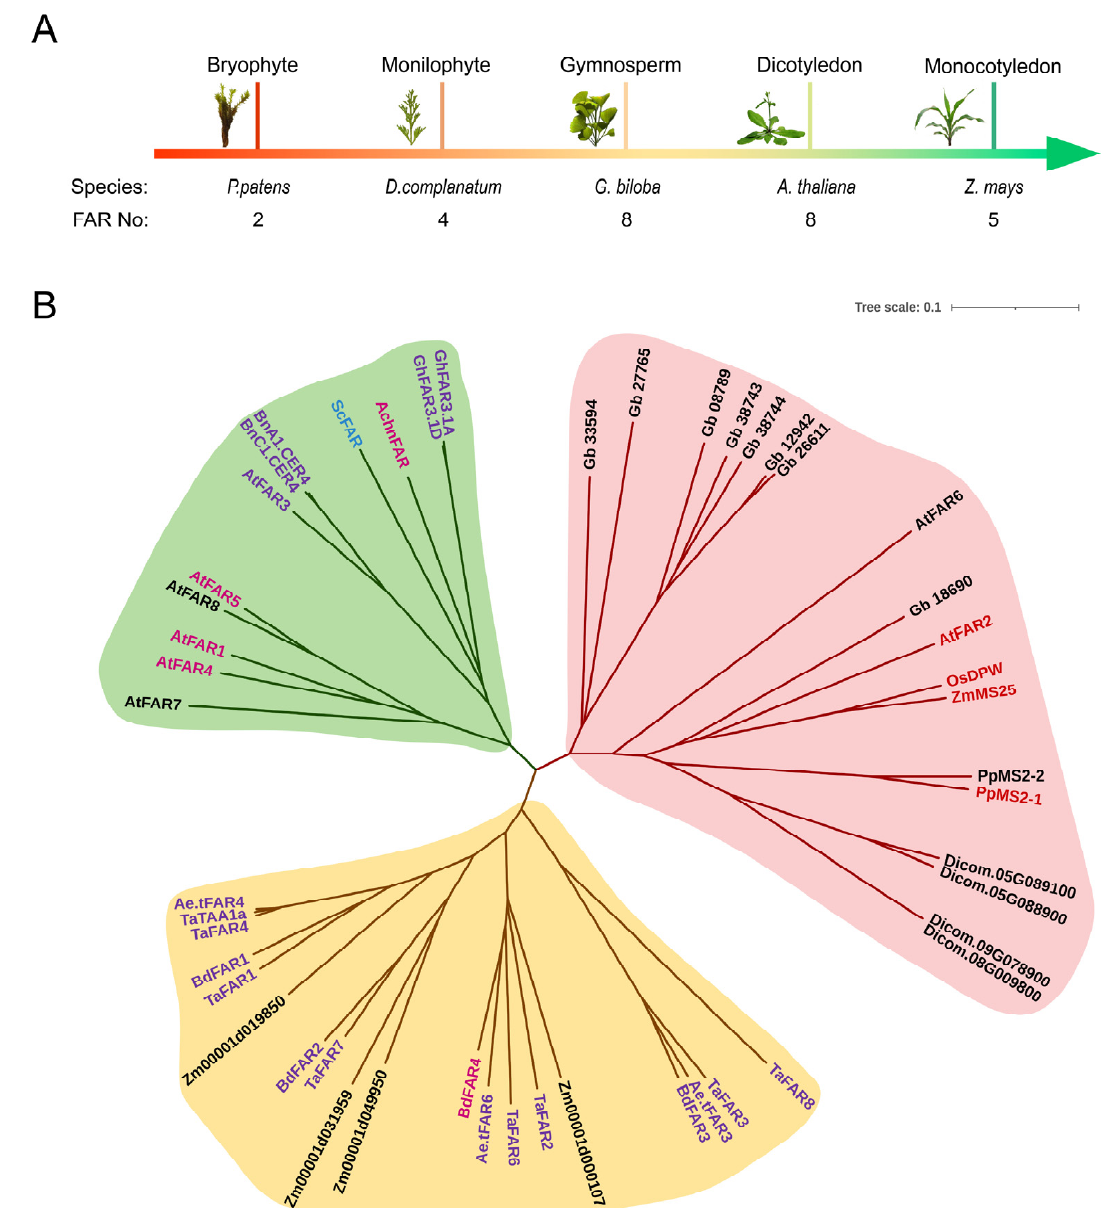
Figure 1. Phylogenetic analysis of plant FARs. ( A ) the number of FAR proteins in the five model species at different stages of terrestrial plant evolution. ( B ) the phylogenetic tree of the FAR members. The analysis involved 49 amino acid sequences from Arabidopsis thaliana (At), Brassica napus (Bn), Simmondsia chinensis (Sc), Actinidia chinensis Planch (Achn), Gossypium hirsutum (Gh), Ginkgo biloba (Gb), Oryza sativa (Os), Zea mays (Zm), Physcomitrella patens (Pp), Diphasiastrum complanatum (Dicom), Triticum aestivum (Ta), Aegilops tauschii (Ae.t), Brachypodium distachyon (Bd). FARs with different colors represent distinct functions. Royal purple is associated with cuticular wax, mauve is associated with suberin, red is associated with sporopollenin, blue is associated with storage wax, and black represents an unknown function. The phylogenetic analysis was conducted by MEGA11.0 software using the neighbor-joining method. The tree is drawn proportionally, and the branch length is the same as the evolutionary distance unit used to infer the phylogenetic tree. Table 1. Substrate specificity, subcellular localization, expression pattern and function of FARs.